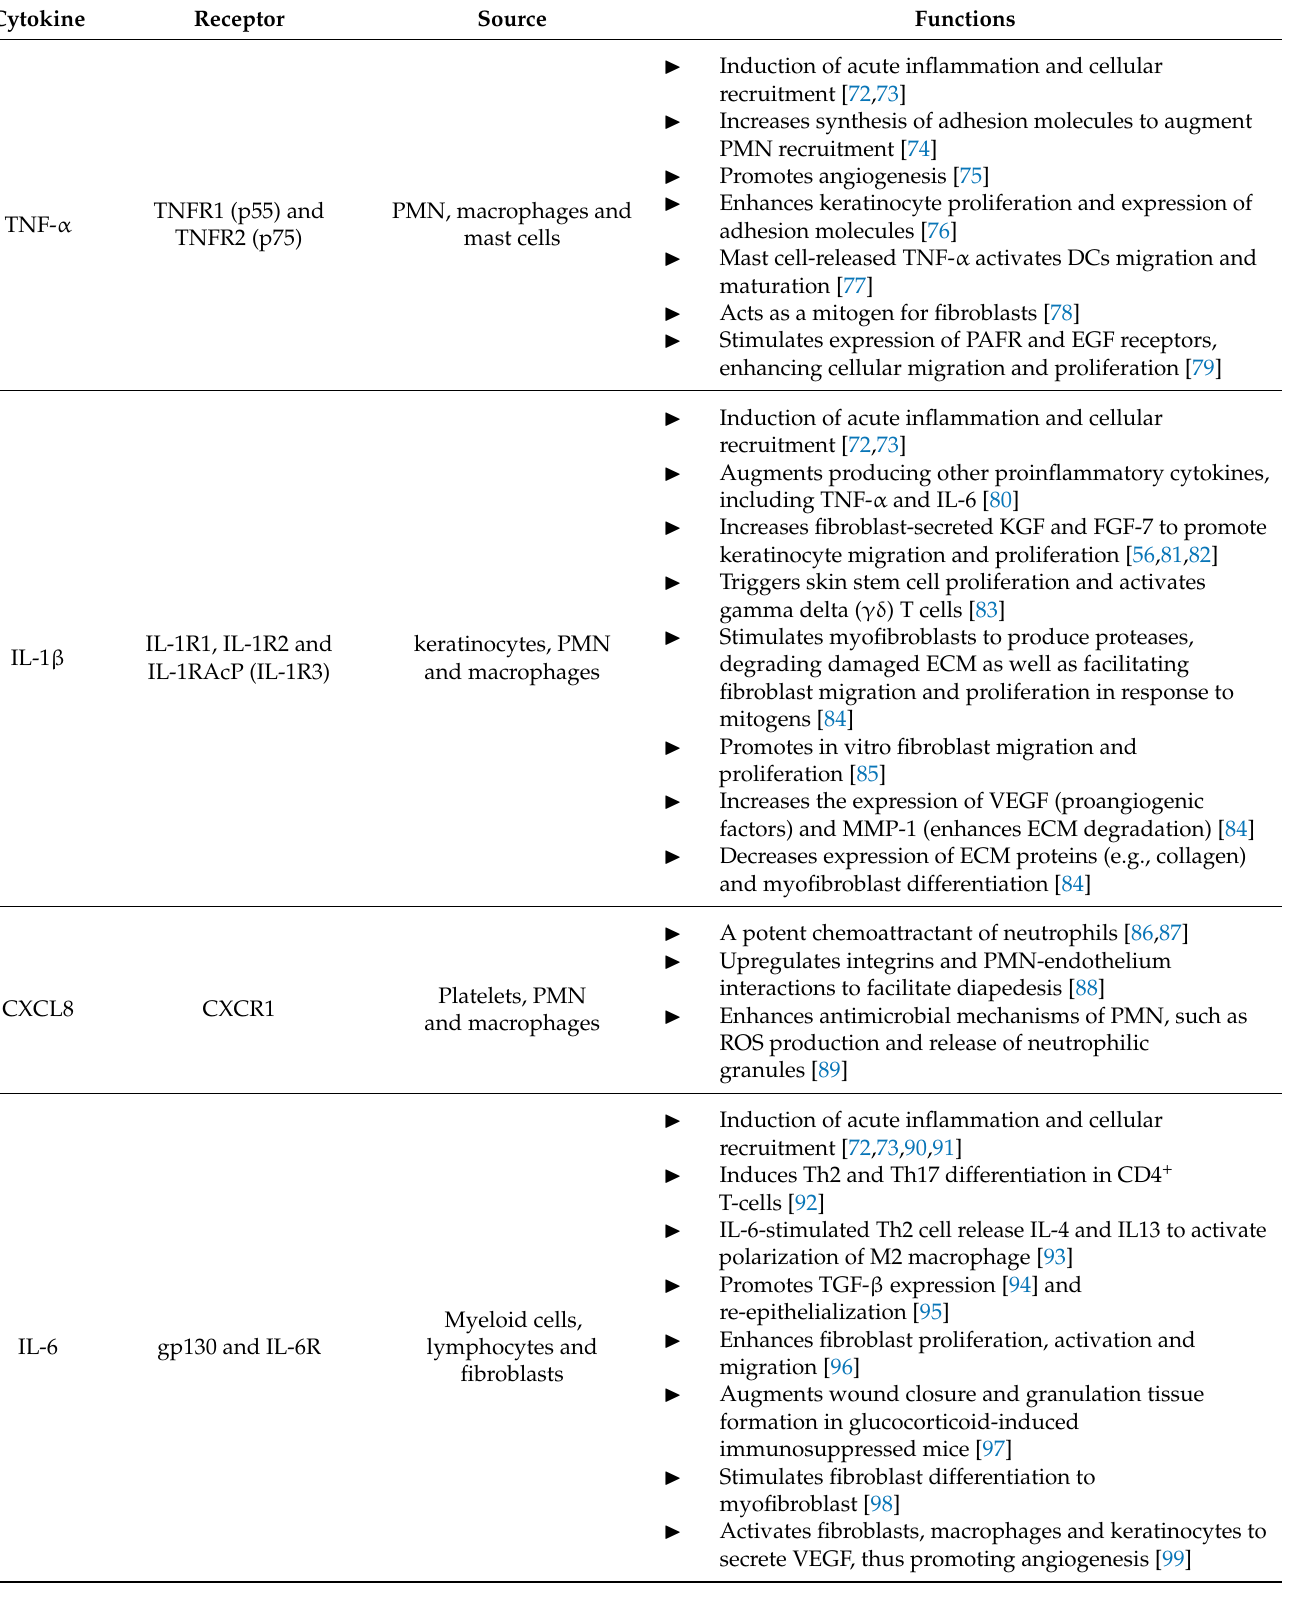
Table 1. Cytokines involved in tissue repair and their potential biological